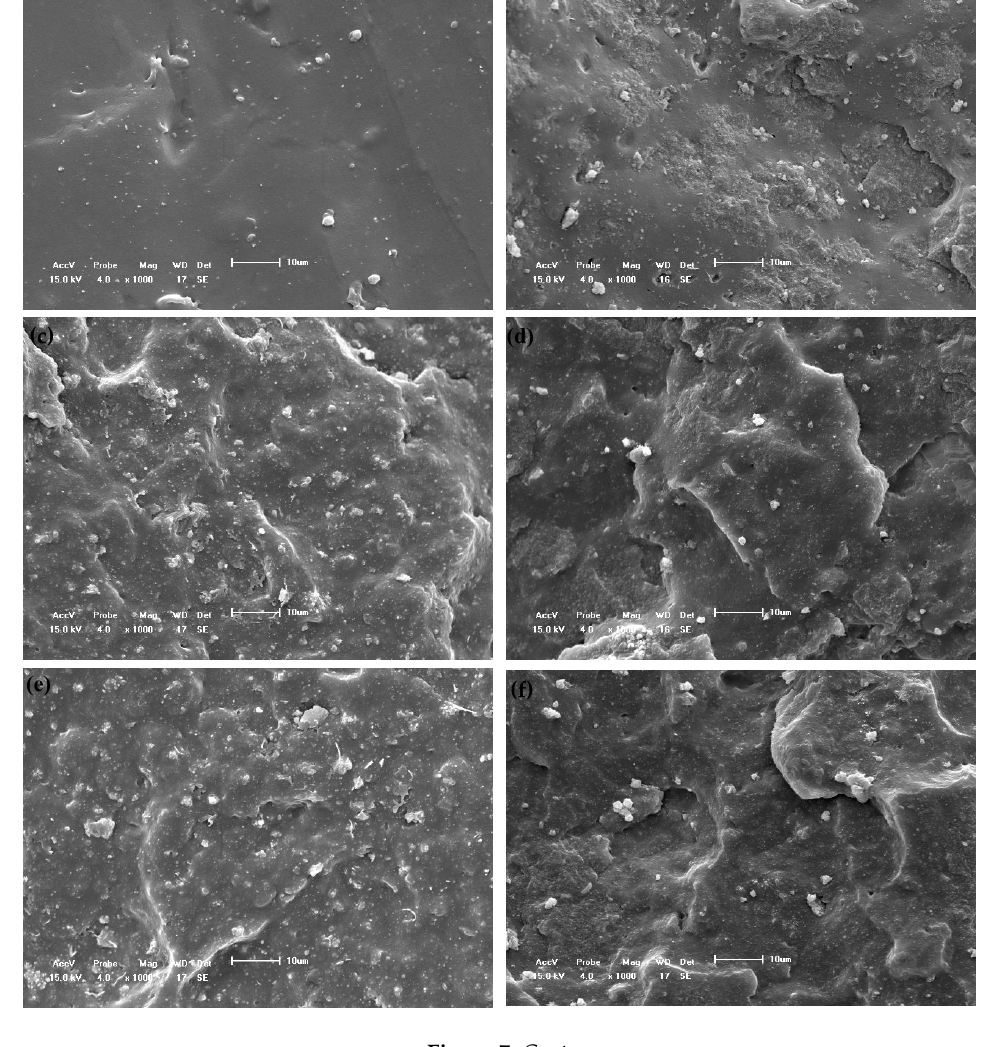
Figure 7. SEM micrographs of the samples: ( a ) 100/0; ( b ) 83/17; ( c ) 71/29; ( d ) 62/38; ( e ) 50/50; ( f ) 45/55; ( g ) 42/58; and ( h ) 42/58